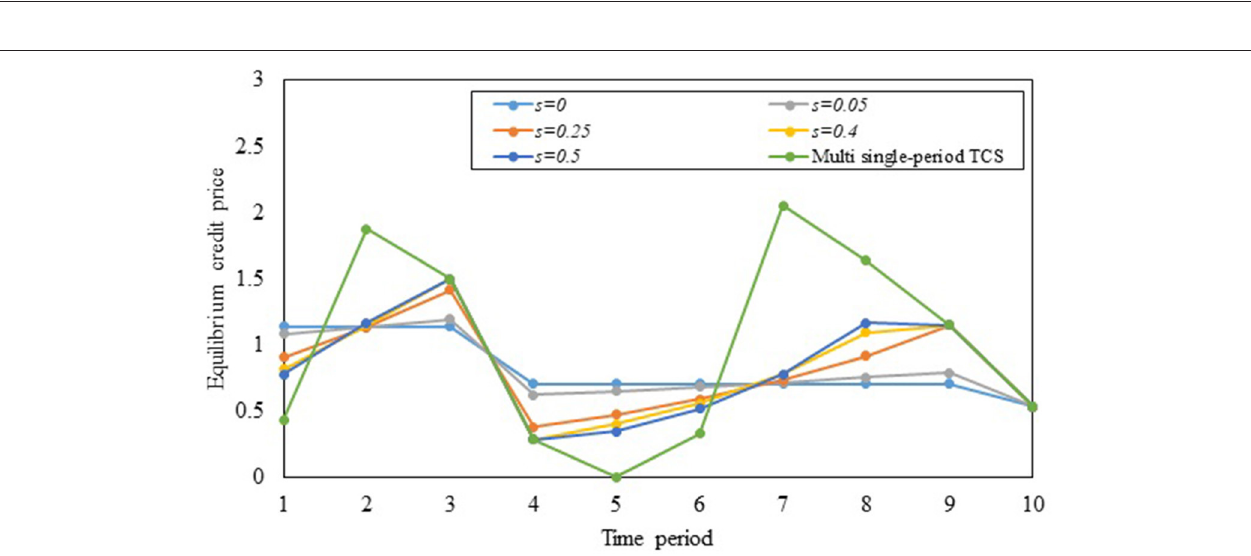
Frontiers in Built Environment | www.frontiersin.org